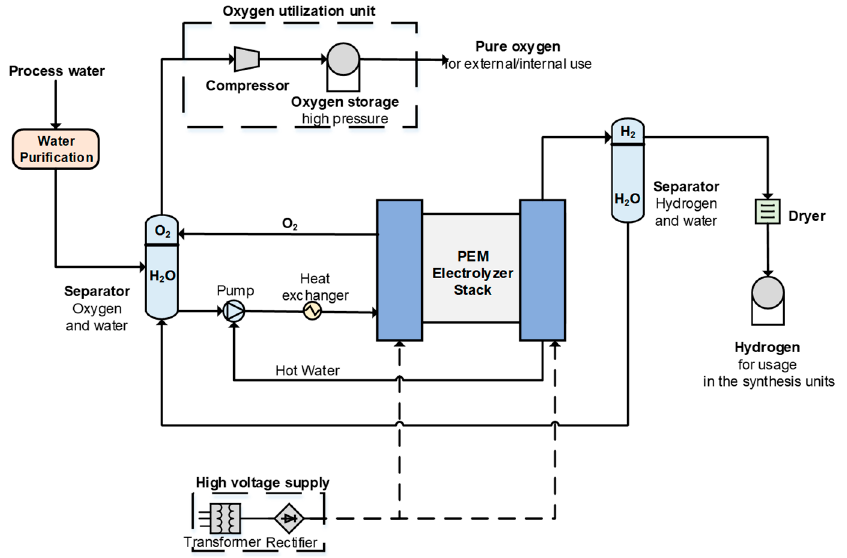
Figure 9. Water electrolysis process flowsheet.